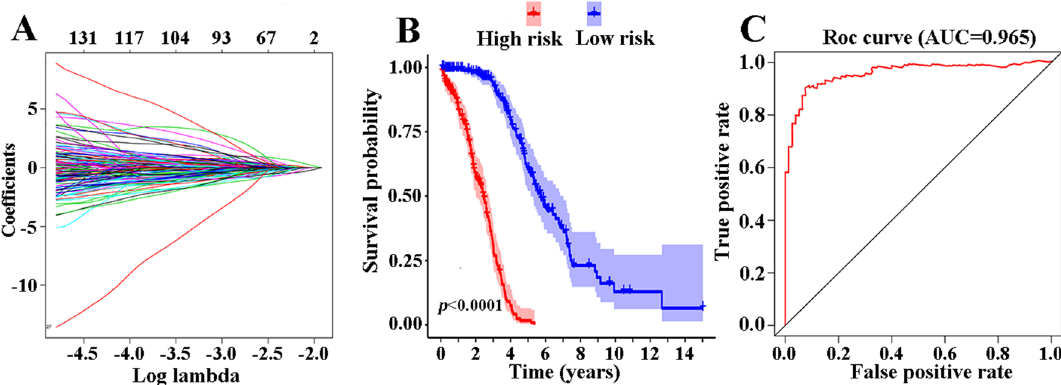
Figure 4. Prognostic signatures for ovarian carcinoma patients. ( A ) LASSO COX analysis in seven types of AS events. ( B ) Kaplan–Meier curves of prognostic predictors for ovarian carcinoma in seven types of AS events. ( C ) ROC curves of prognostic predictors for ovarian carcinoma in seven types of AS